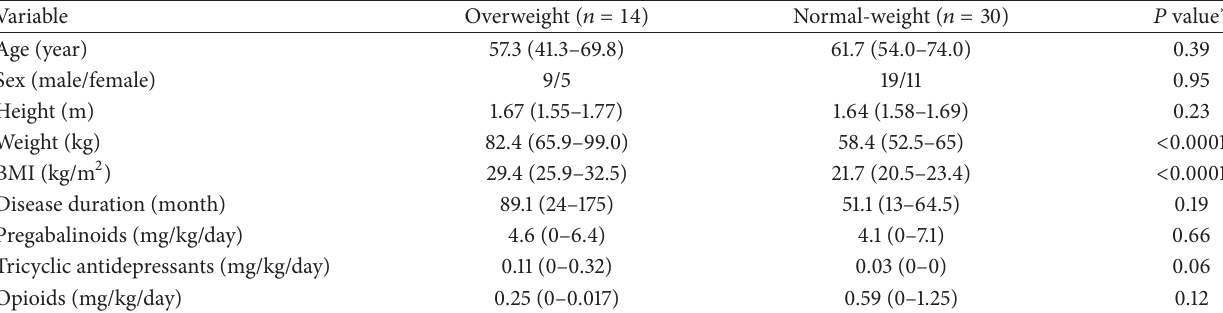
Table 1: Clinical characteristics of the